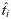
Overall flow of RefShannon.In this example, the true transcriptome contain 3 RNA transcripts t1, t2, t3 with expression levels f1 = 1, f2 = 2, f3 = 4. RNA reads are sampled from the transcriptome first, and are aligned onto a reference genome using external aligners. RefShannon will take the read alignment as input, generate splice graphs, and apply a novel sparse flow decomposition algorithm to recover the transcriptome as ti^
i ∈ {1, 2, 3}. The corresponding fi^ estimates related abundance.